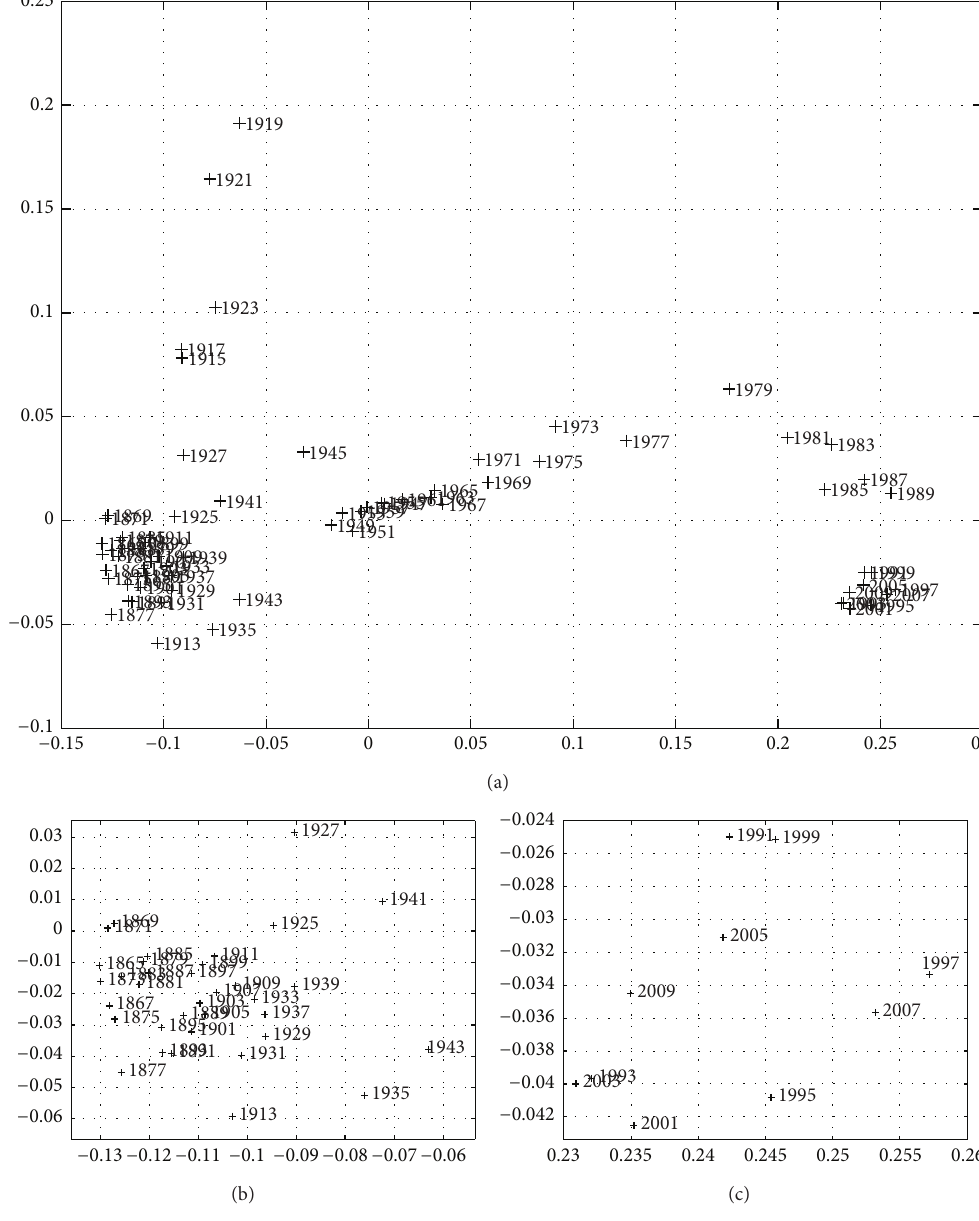
Figure 3: Two-dimensional MDS map of the Portuguese economic evolution, in the perspective of the Cosine correlation 𝑟 𝐶 , 𝑇 = 1865 – 2010 , and ℎ = 2 years. The two charts magnify the two clusters in the left and right lower